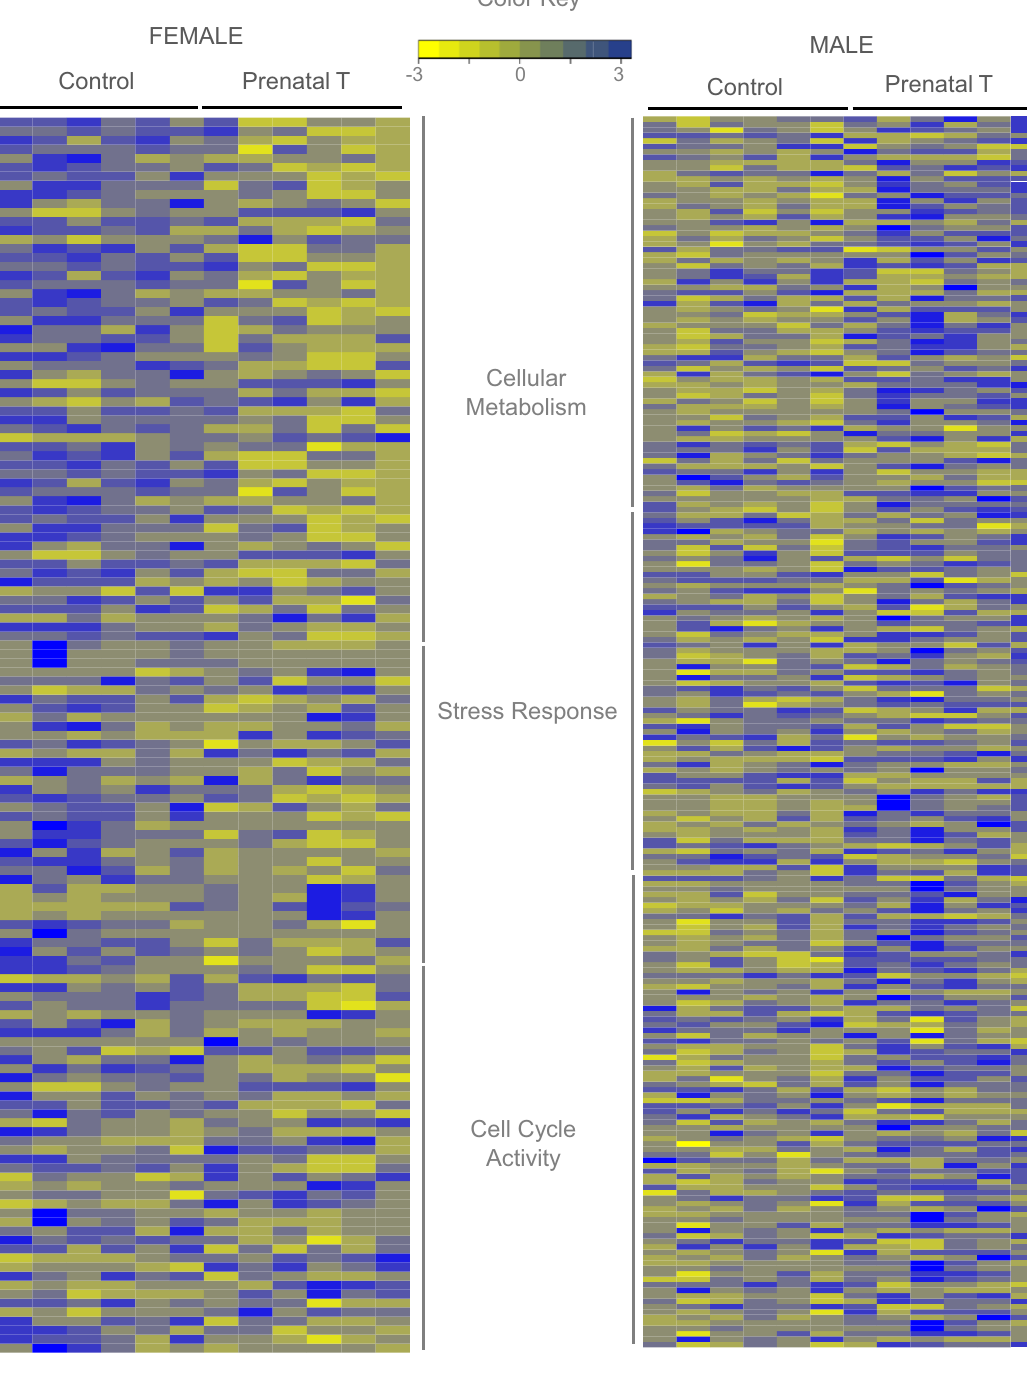
Figure 4. Expression Levels of Genes in Commonly Dysregulated Pathways between Male and Female in Response to prenatal T. Heatmap showing genes involved in the pathways representing metabolism, response to stress and cell cycle activity that is dysregulated in both female (C = 6, T = 6) (left panel) and male (C = 6, T = 6) (right panel). The genes associated with the gene pathway in controls animals and prenatal-T treated animals are plotted along a gradient of colors, with blue representing highest and yellow the lowest normalized